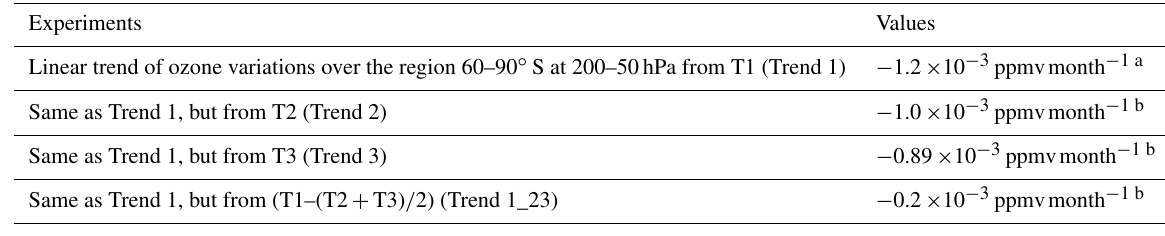
Table 4. Linear trends of ozone variations over the region 60–90 ◦ S at 200–50hPa from experiments with (T1) and without (T2 + T3) SST variations in the East Asian marginal seas (T1–T3; see Table 3).